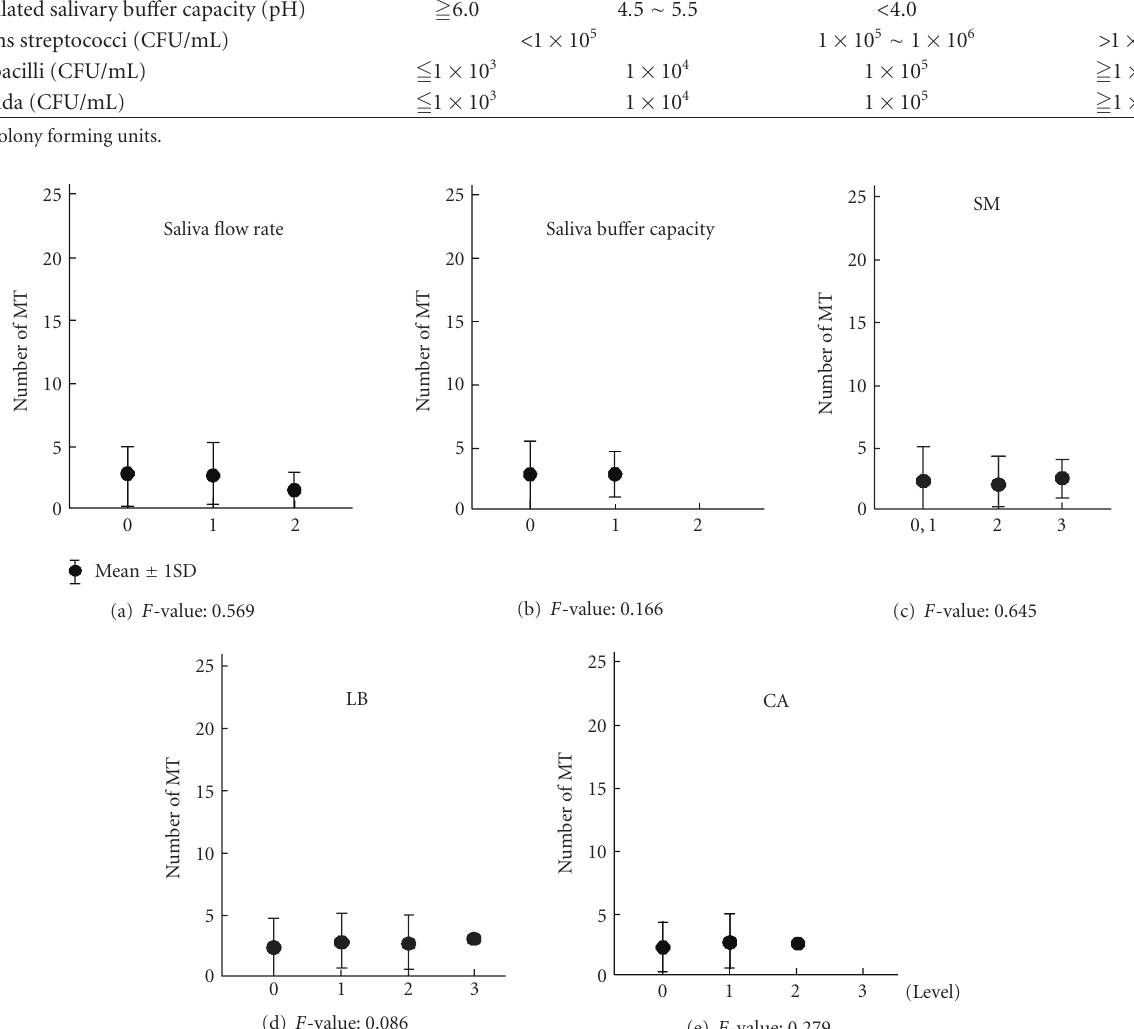
Figure 1: Results of the di ff erences between MT and oral environmental factors in Dentate